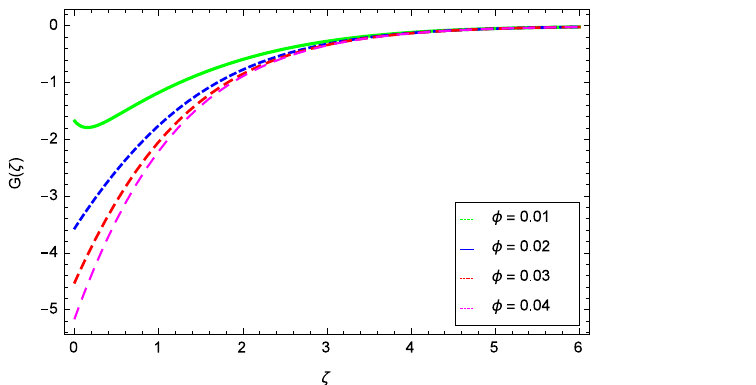
Figure 22. Effect of φ on tangential velocity G (ζ) .